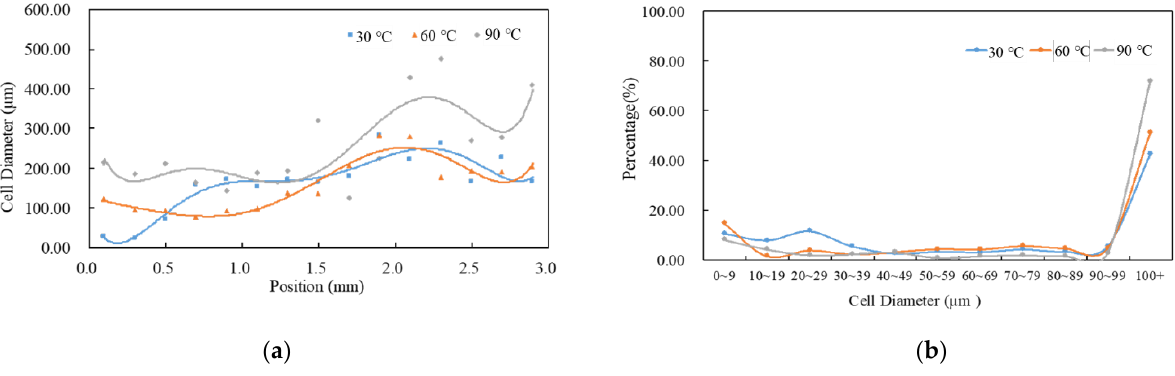
Figure 4. Distribution of cell sizes under different mold temperatures at P3. ( a ) Cell diameter distribution across the thickness section. Here, 0 represents part skin location and 3 represents thickness center location. ( b ) Overall cell diameter distribution. Table 5. Averaged cell density at different injection